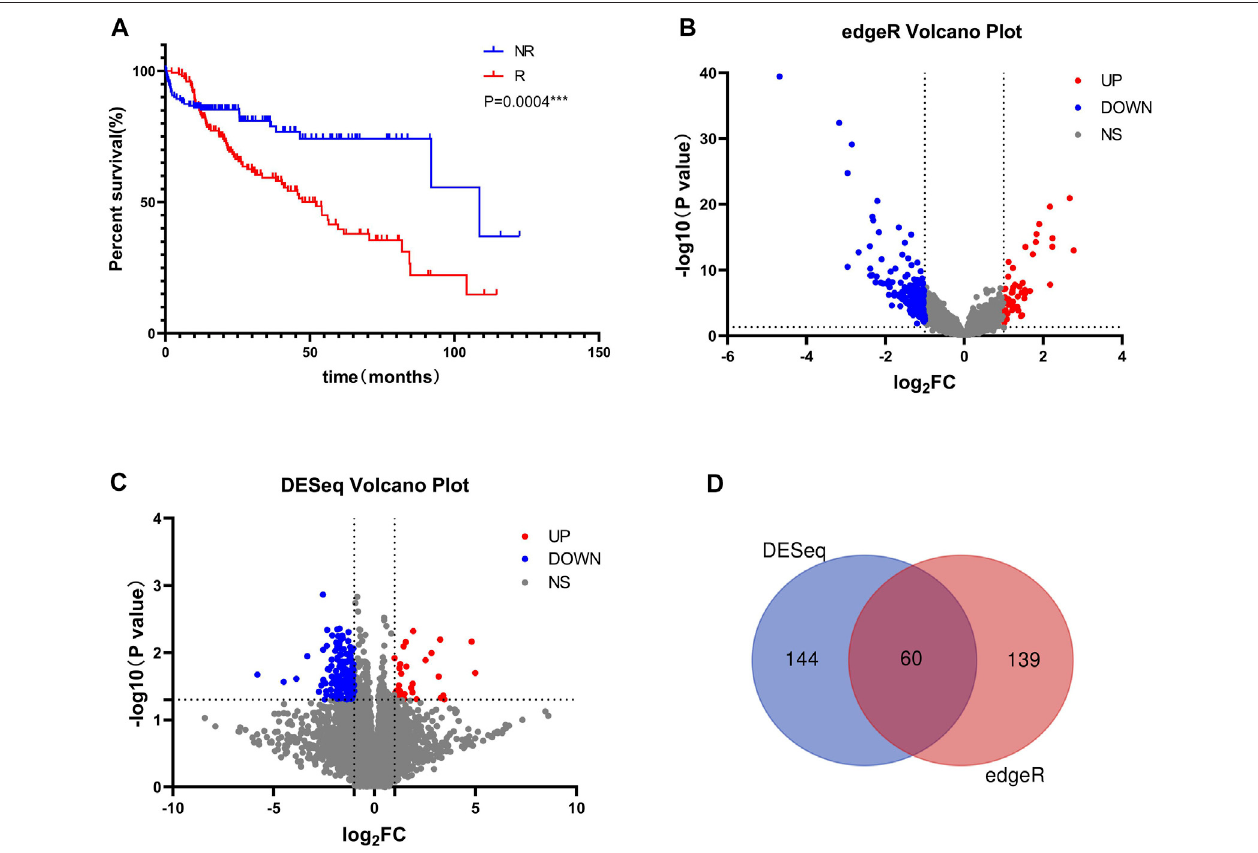
FIGURE 1 | Identi fi cation of DE-mRNAs (A) Kaplan-Meier curves of OS between the recurrence and non-recurrence groups across the entire dataset (B) DE- mRNAs that identi fi ed using the edgeR package (C) DE-mRNAs that identi fi ed using the DESeq package (D) Overlapping DE-mRNAs between the selection methods.